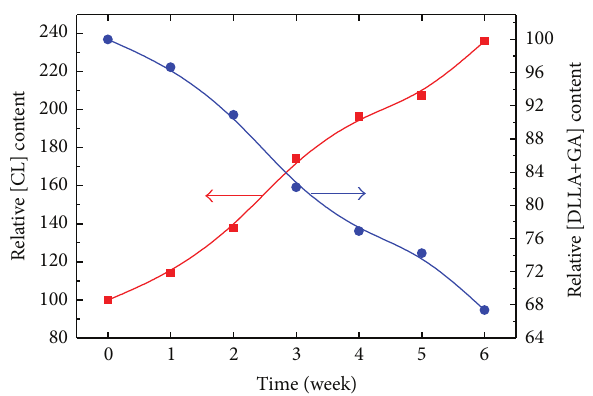
Figure 6: The changes in composition of the PLGC copolymer (20 mol% CL) in vitro hydrolytic degradation as function of degra- dation time.